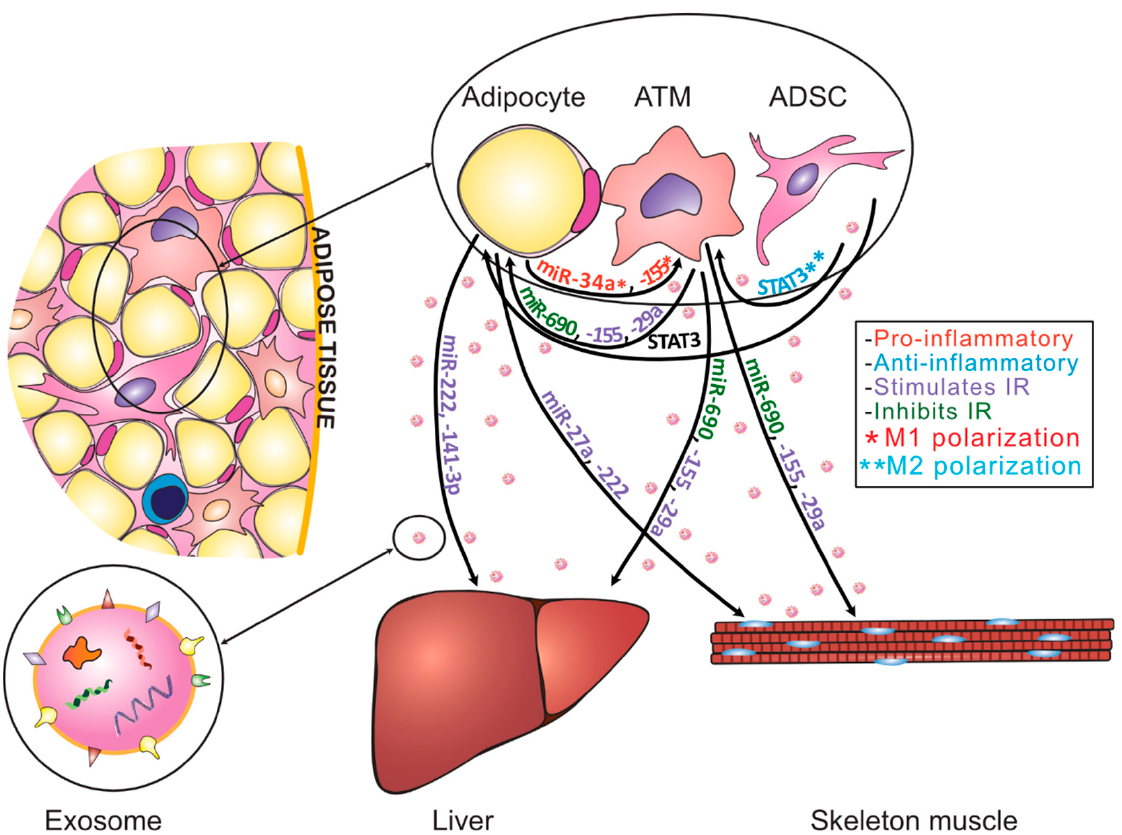
Figure 2. Graphical summary of adipocytes, ATMs, and ADSCs-derived exosome composition and their targets. The color of the factor indicates its overall effect. Red: miR-34a [50] and miR-155 [52] are produced by obese adipocytes and lead to M1 polarization of macrophages and tissue inflammation. Blue: STAT3 is produced by ADSCs and inhibits tissue inflammation by induction of M2 polarization of macrophages [25]. Purple: miR-27a [49], -29a [46], -155 [47], and -222 [48] are released by obese adipocytes and M1 ATMs, and induce IR in insulin sensitive tissues. Downregulation of exosomal miR-141-3p release by obese adipocytes induces insulin resistance in liver [60]. They are responsible for the induction of IR in WAT, liver, and skeletal muscle by decreasing the glucose uptake or impairing tissue-specific insulin signaling. Green: miR-690 is produced by M2 macrophages and increases insulin-stimulated glucose uptake and enhances insulin-mediated suppression of glucose output; increases in insulin-stimulated AKT phosphorylation [45]. Black colored STAT3 stimulates transformation of WAT into beige fat tissue, improving its metabolic function [25]. IR—insulin resistance; *M1 polarization of macrophages; **M2 polarization of macrophages.